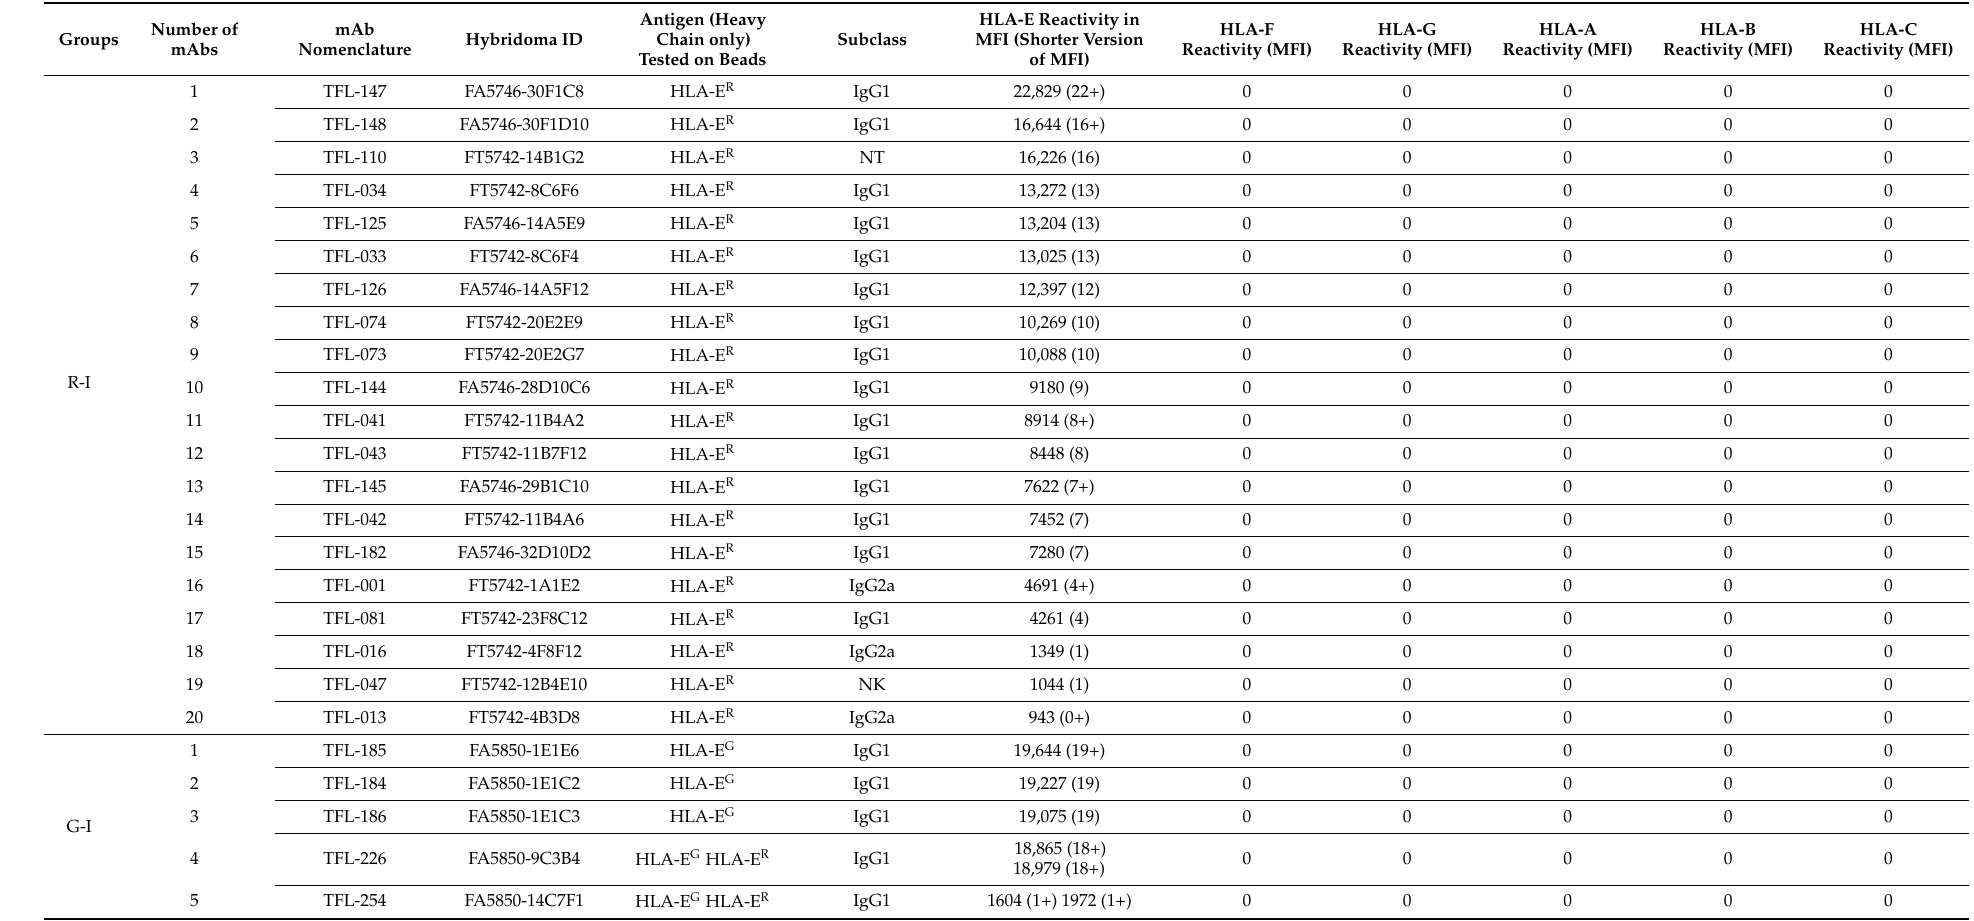
Table 2. HLA-E monospecific mAbs identified with their hybridoma and subclass, produced after immunizing mice with recombinant (non-glycosylated); HLA-E R107 and HLA-E G107 heavy